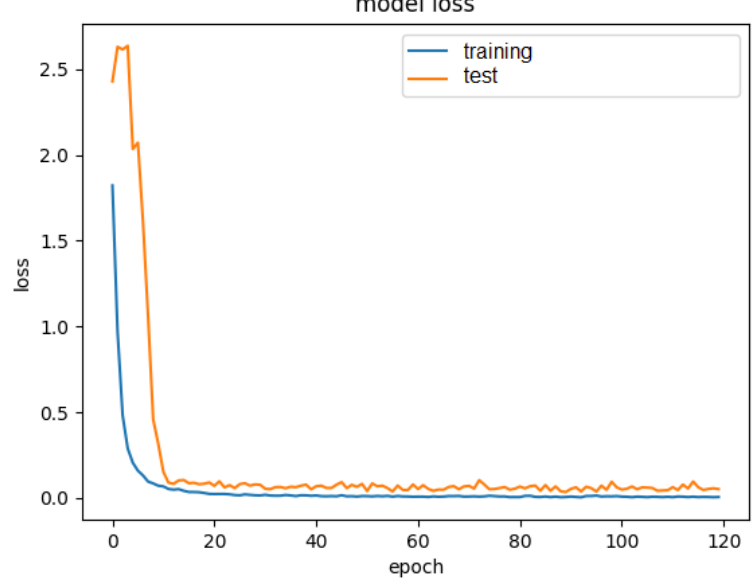
Figure 7. Training and test loss values with respect to